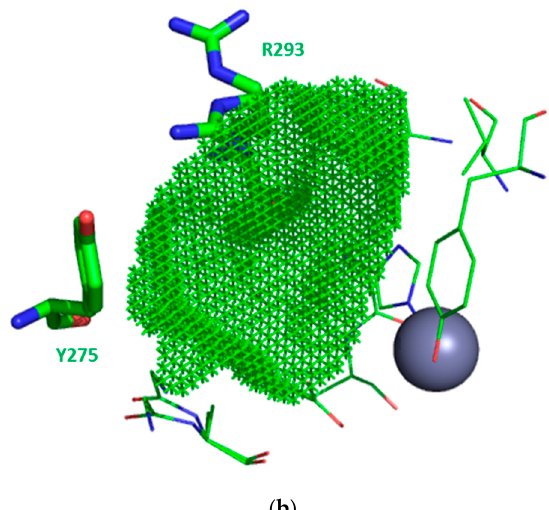
Figure 4. Diversity in the S1’ subsite of different M1 aminopeptidases. ( a ) Superimposition of the protein backbone of S1’ subsite of different M1 APs: Hs APN (cyan, PDB 4FYT), Hs ERAP1 (orange, PDB 2YD0), Hs ERAP2 (yellow, PDB 4JBS), Hs IRAP (white, PDB 5MJ6), Ec PepN (green, PDB 5MFS), Pf AM1 (magenta, PDB 3EBH). ( b ) Surface representation of the S1’ subsite of Ec PepN (green, PDB 5MFS). The catalytic zinc ion is shown as grey sphere. Residues involved in S1’ plasticity are shown in stick. Images generated with KVFinder plugin in PyMOL.